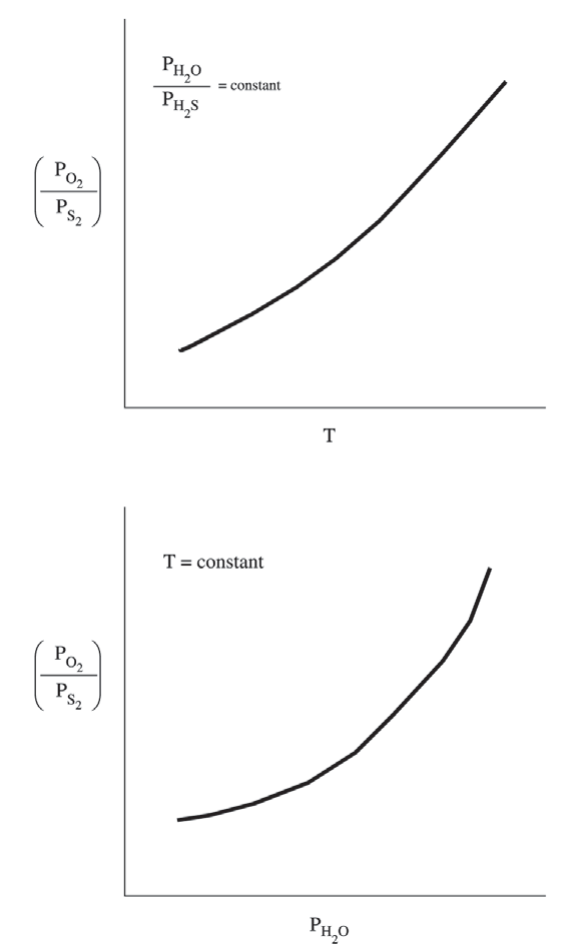
Figure 1. Dependence of P -H O-H S an H 2 2 2